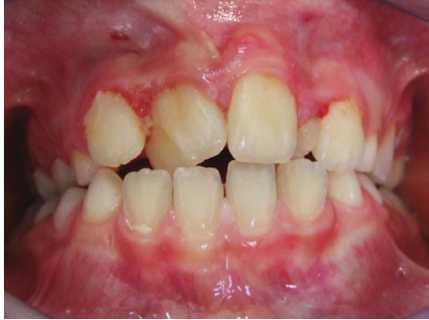
Figure 2: View of the supernumerary incisor (arrow), which erupted 4 months after the initial